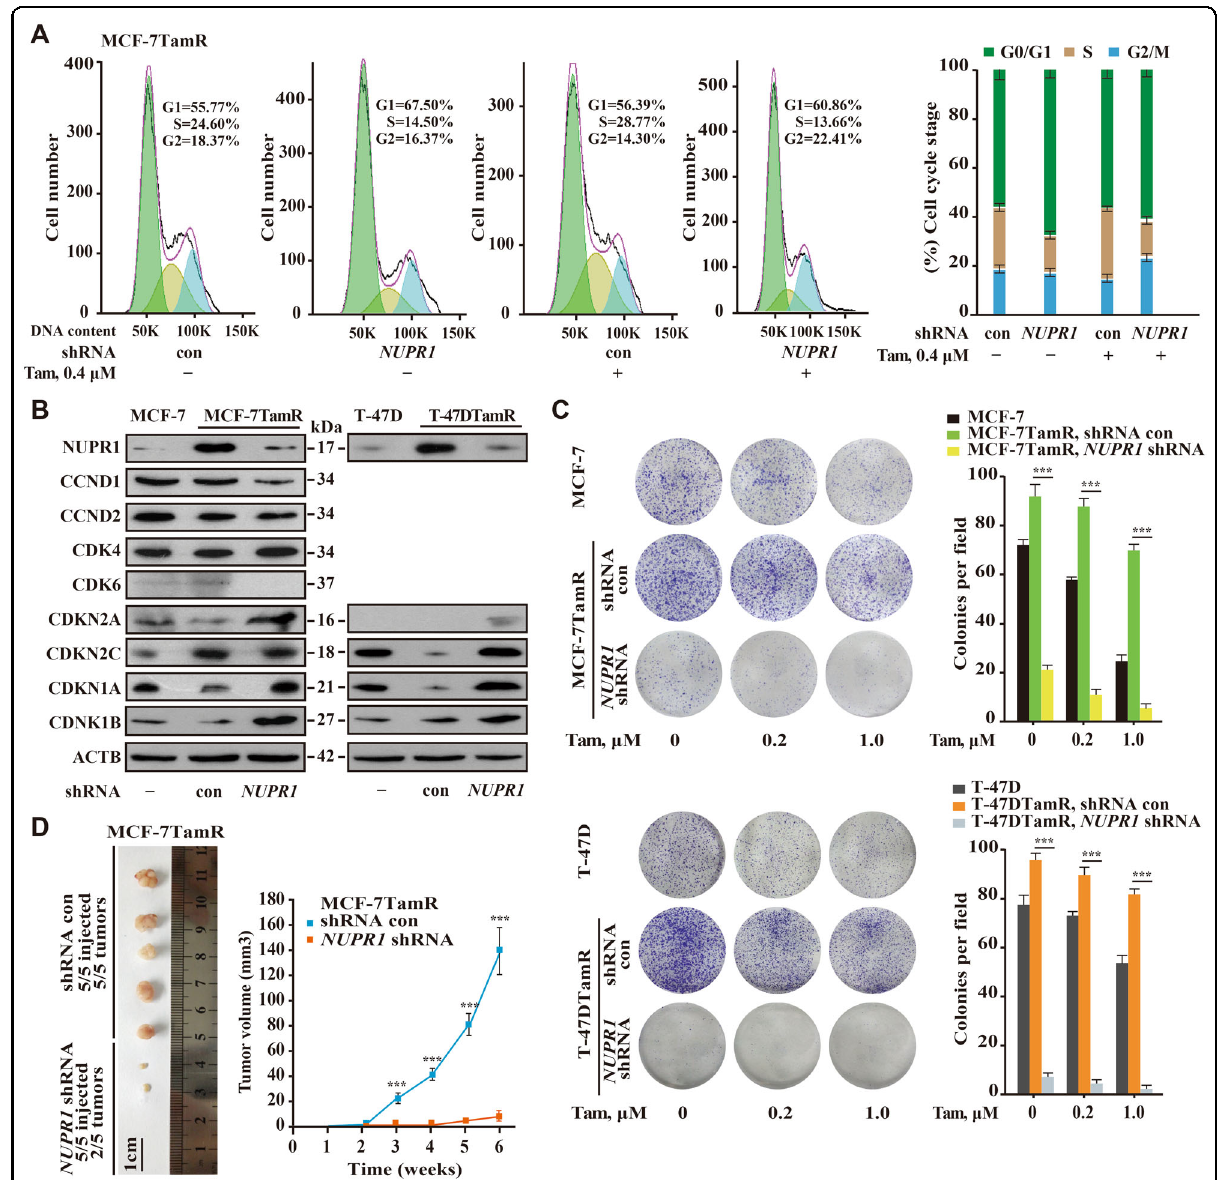
Fig. 3 NUPR1 depletion overcomes Tam resistance in vitro and in vivo. A Cell cycle analysis by fl ow cytometry of NUPR1 -depleted MCF-7TamR cells, treated with vehicle (ethanol) or 0.4 μ M Tam. The percentage of cells in G0/G1, S, and G2/M phases were determined from three independent experiments (right panel, mean ± SD). B Immunoblot of the indicated proteins in cells upon NUPR1 depletion by shRNA, with ACTB as a loading control. C Representative images of the clonogenic assay in MCF-7TamR or T-47DTamR cells upon NUPR1 depletion and their corresponding shRNA con cells. The percentage of colonies is expressed in bar graphs (right panel) as the mean ± SD. of three separate experiments, each performed in triplicate. *** P < 0.001, compared to the shRNA control cells. D NUPR1 -depleted MCF-7TamR cells were orthotopically and bilaterally implanted into the mammary fat pads of female nude mice ( n = 5). Microphotographs of tumors collected (left panel) at 6 weeks after injection and the tumor growth curve (right panel, mean ± SD) are shown. *** P < 0.001, compared to the shRNA control